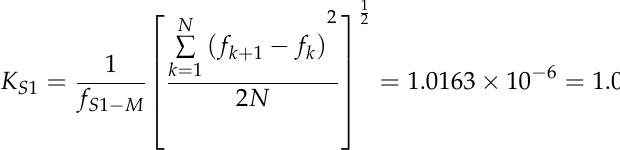
Table 3. Frequency fluctuations test data of SAWO1 from 600 s to 3600 s when F = 100 cN (the group where the greatest fluctuation occurred, and the red color is the maximum data for this group of tests).